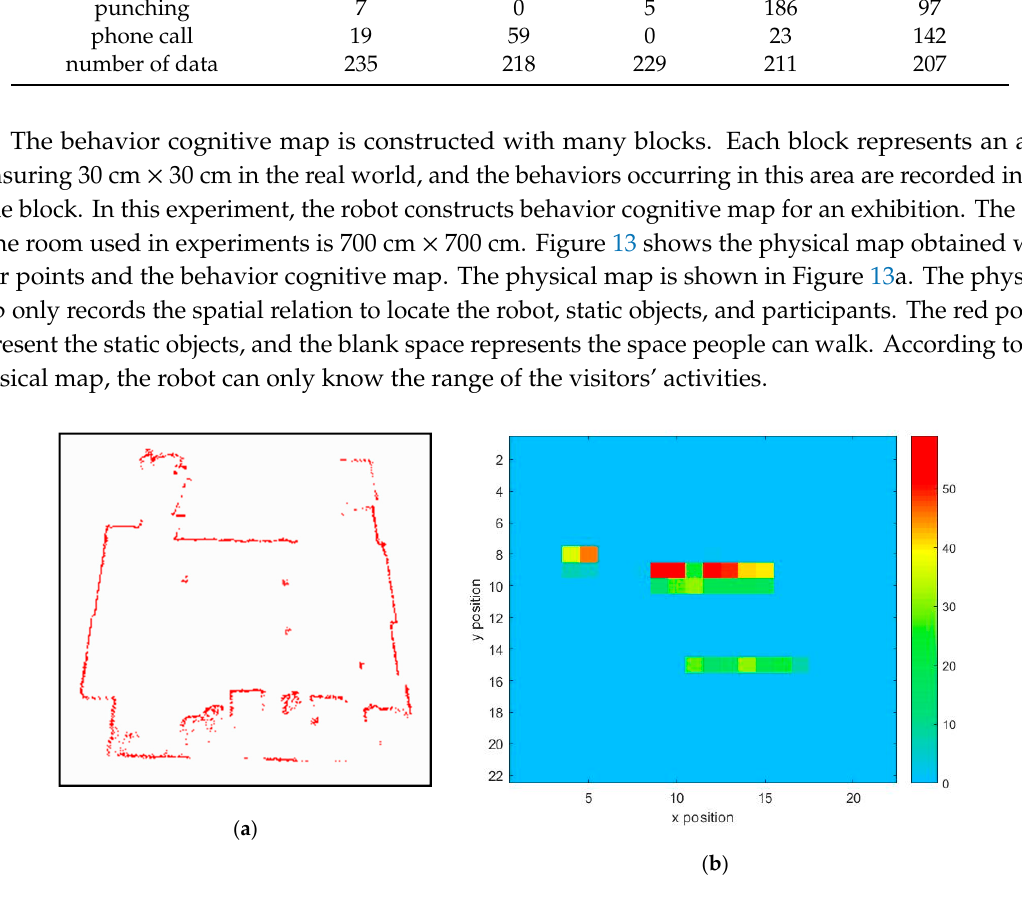
Figure 13. Comparison of physical map and behavior cognitive map. ( a ) Physical map ( b ) Behavior cognitive map.